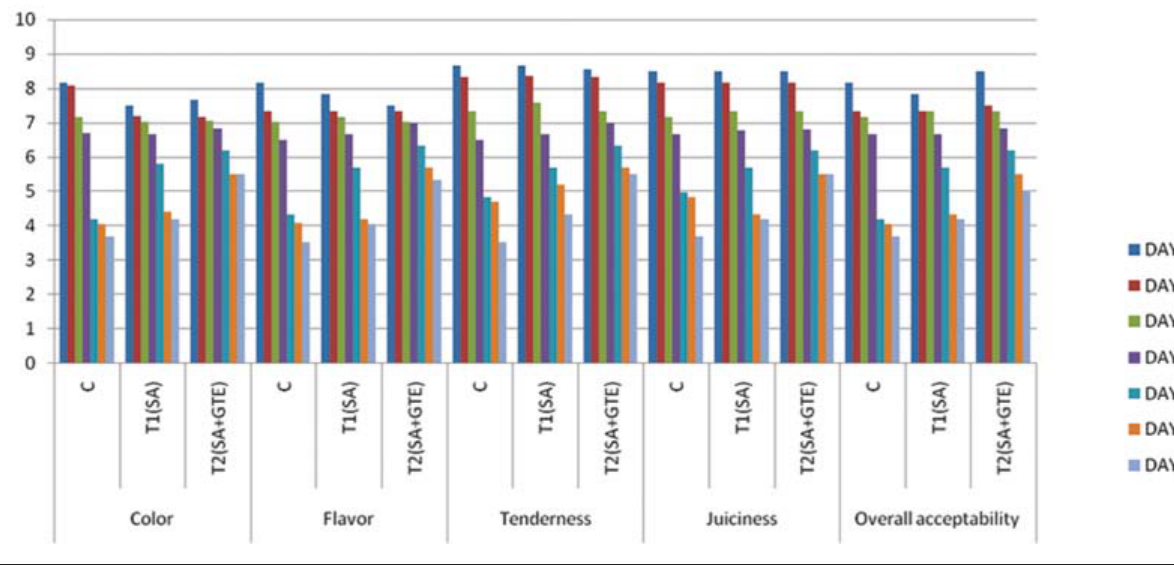
Figure-2: Sensory evaluation of chicken nuggets at frozen